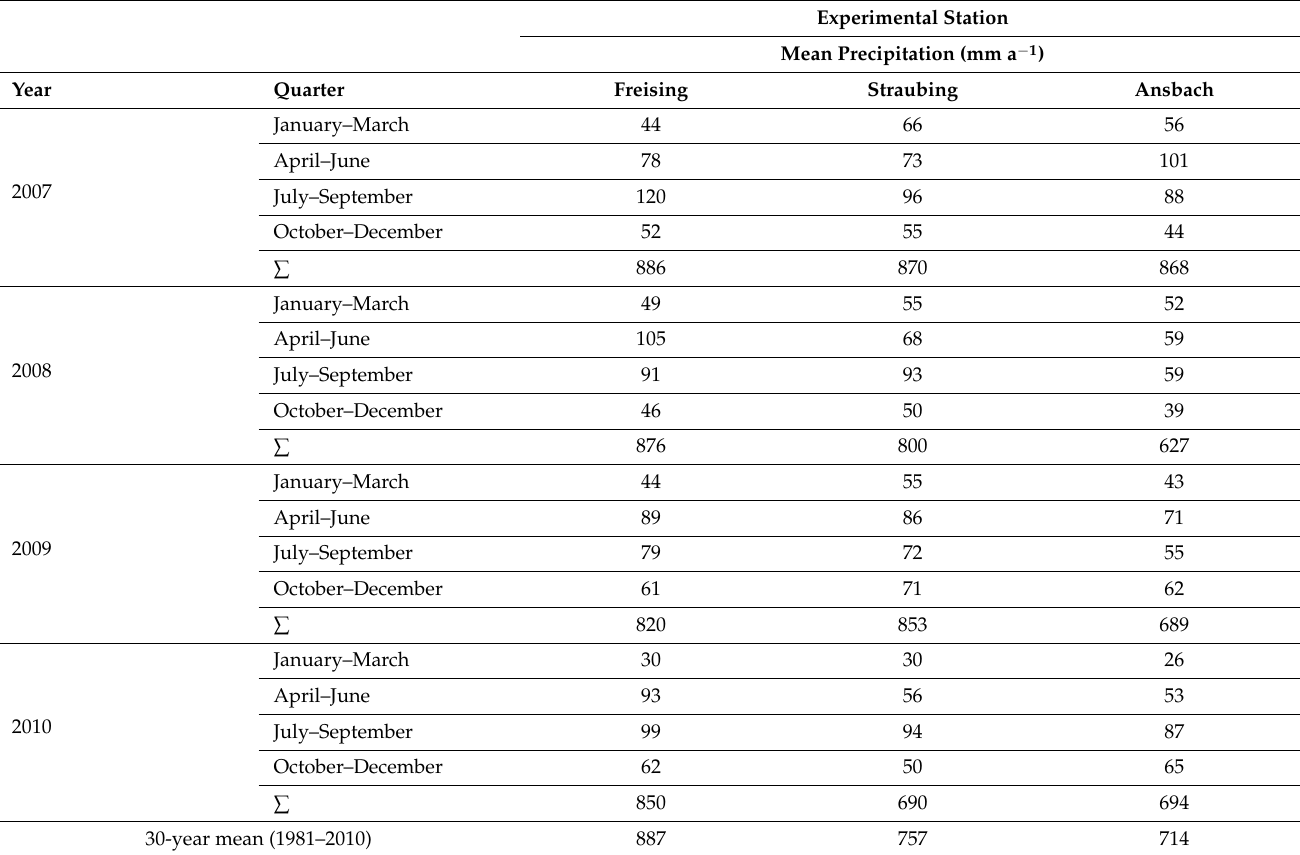
Table A1. Mean trial year precipitation at the experimental sites.